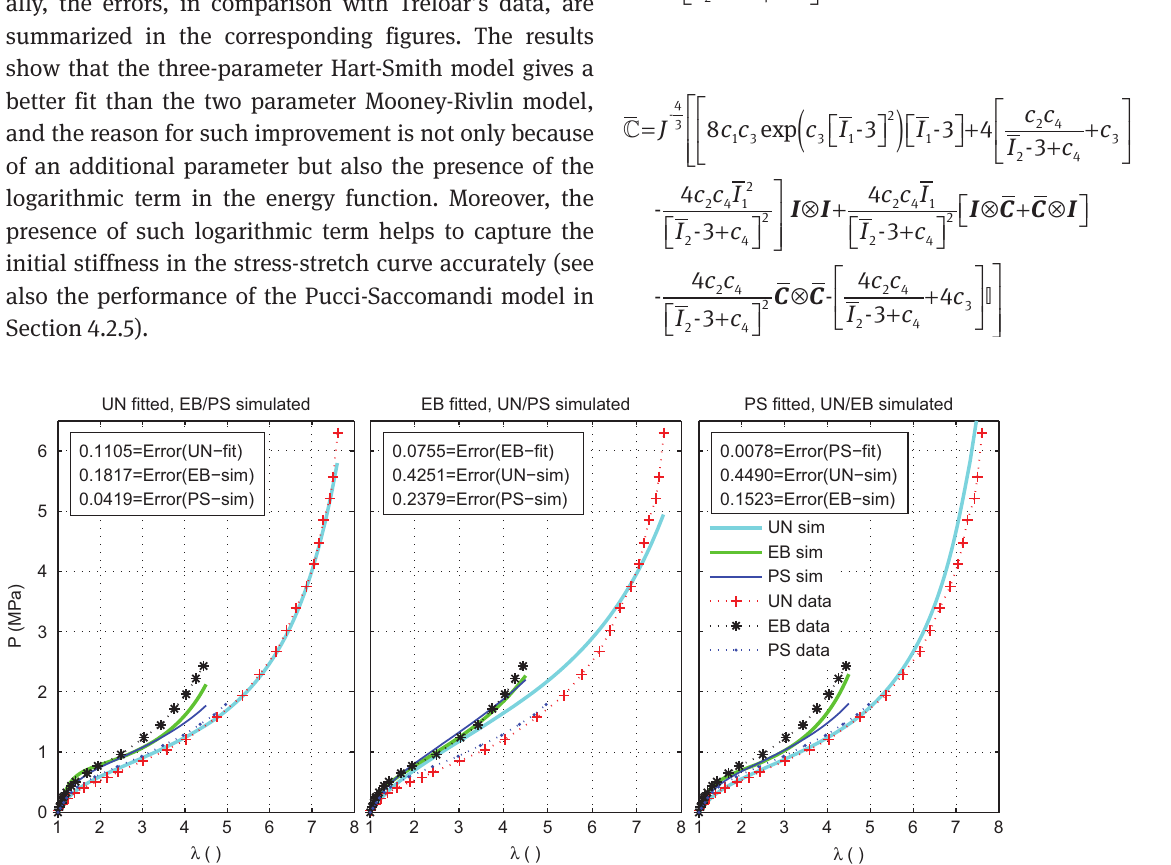
Figure 5 Comparison between the Hart-Smith model and the Treloar